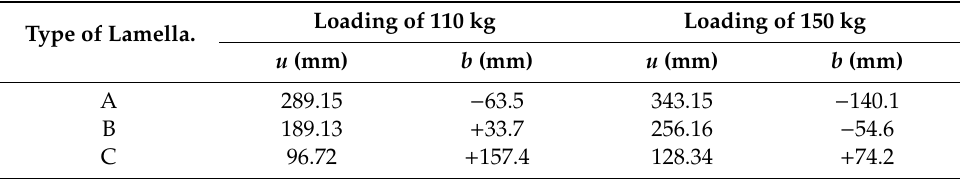
Table 5. Maximum values of the backward displacement of the back u (mm) and values of the distance of the centre of gravity of the load from the tipping b (mm) in the direction of x-axis. Type of Lamella.